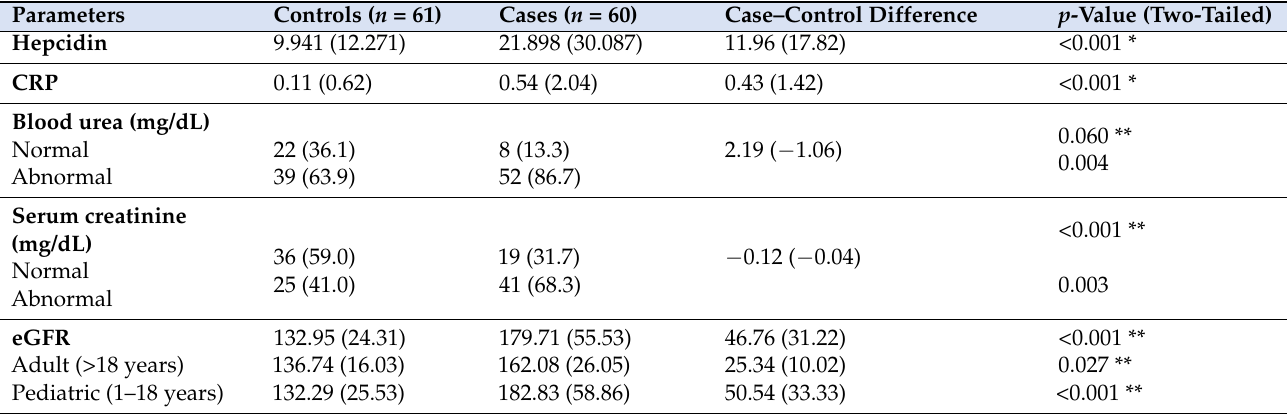
Table 2. Comparison of hepcidin, CRP and renal function parameters between patients with β -thalassemia major and their matched controls.